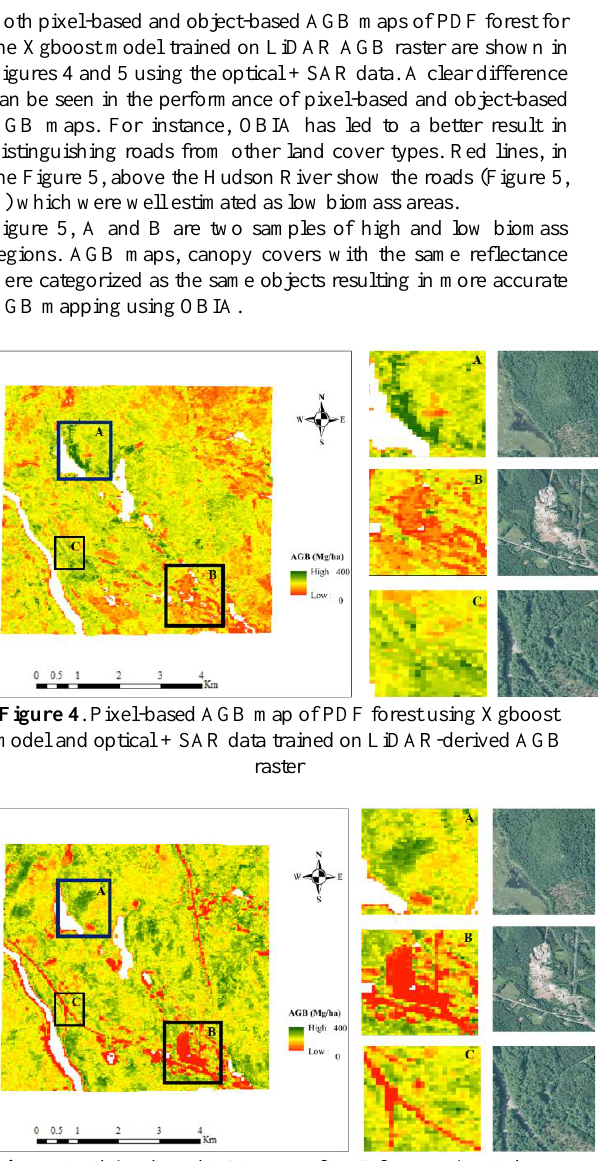
Figure 5 . Object-based AGB map of PDF forest using Xgboost model and optical + SAR data trained on LiDAR-derived AGB